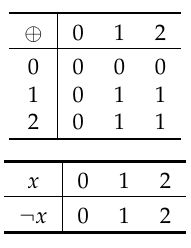
Table 1. Operations tables for the independence of ( MV 1 (cid:48) )